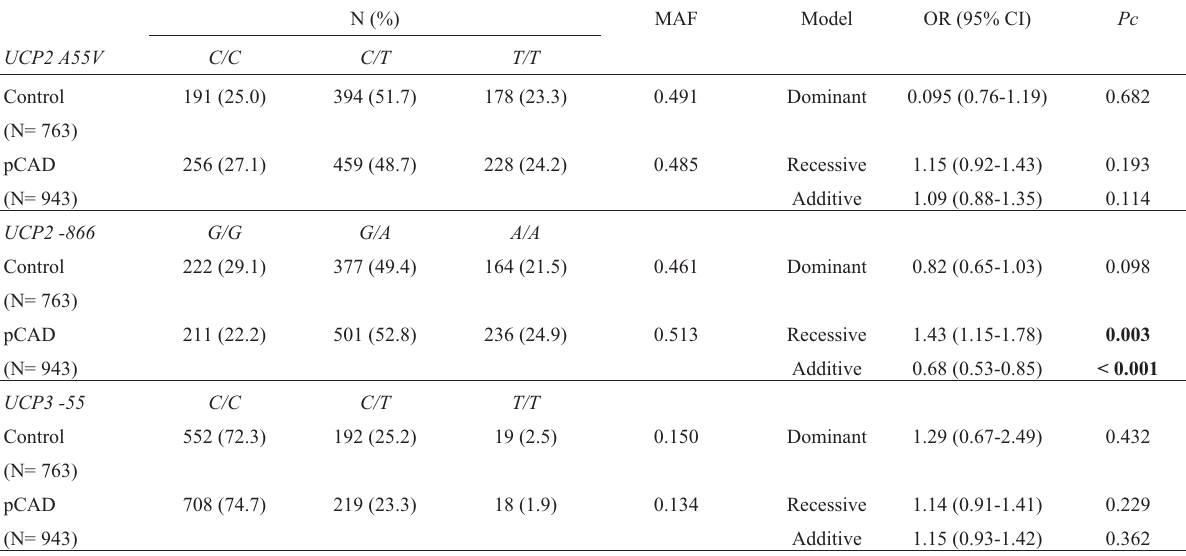
Table 3 - Association of UCP polymorphisms with